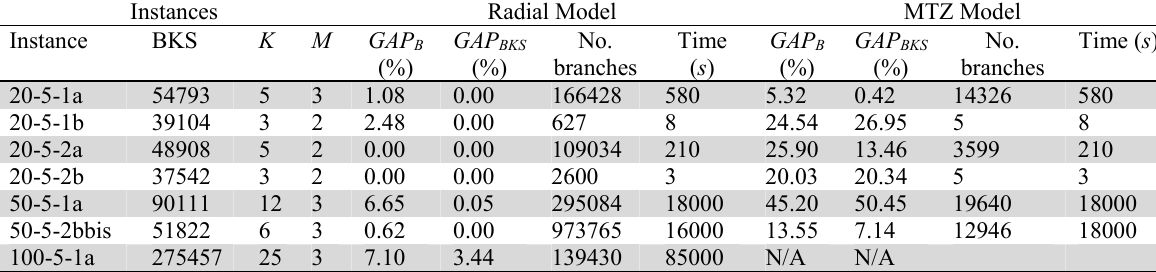
Results for the instances of the